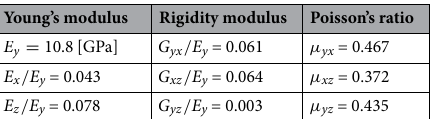
Figure 7. ( a ) Histogram of mean frequencies for datasets varying shape, thickness profile and material parameters. ( b ) First 20 eigenfrequencies for the two most different violin top plates (in their parameters) that are in the top 0.1% of most similar frequency response in the data set (the complete data set is plotted on the background for comparison). ( c ) Outline and thickness profile of the same two violin tops. and their most important material parameters. The black outline is slightly wider than the red one and the lower corners point more upwards; the most relevant difference is in the thickness profile though. Young’s modulus Rigidity modulus Poisson’s